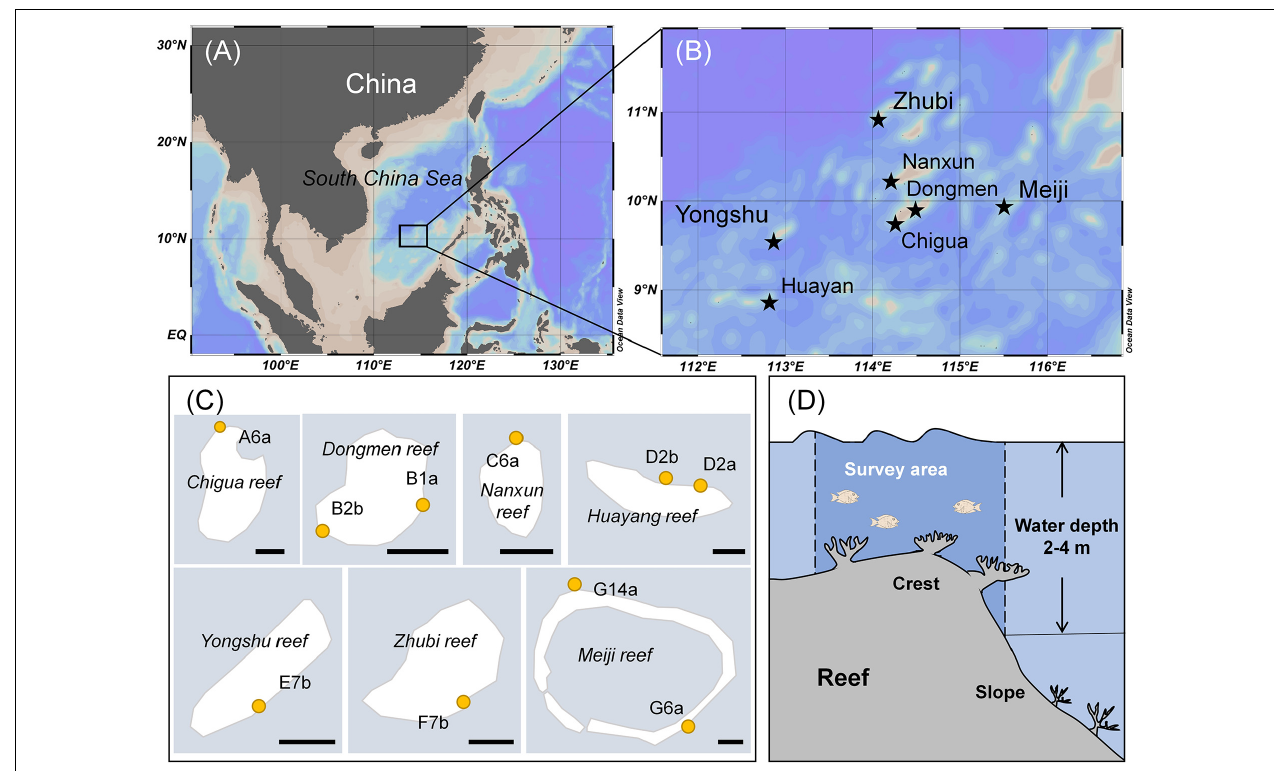
FIGURE 1 | Location of surve yed sites and area on the reefs in the southern part of the South China Sea. Seven reefs were surveyed (A,B) and all the sites were located on the windward side of reefs. The solid line on the scale at the bottom right of the figure represents 1 km (C) , and surveyed areas were the seaward reef crests at a depth of 2–4 m (D)